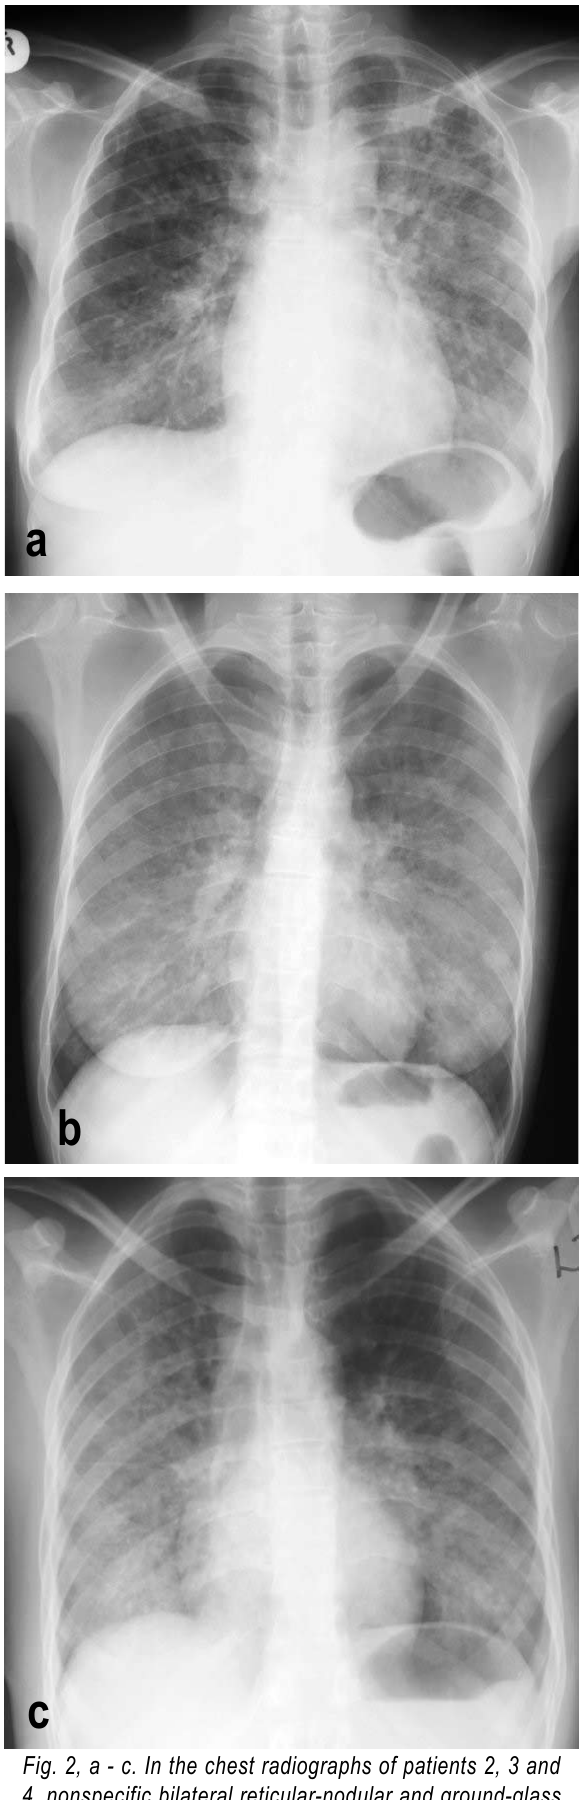
Fig. 2, a - c. In the chest radiographs of patients 2, 3 and 4, nonspecific bilateral reticular-nodular and ground-glass opacities were present with no features of an effusion.